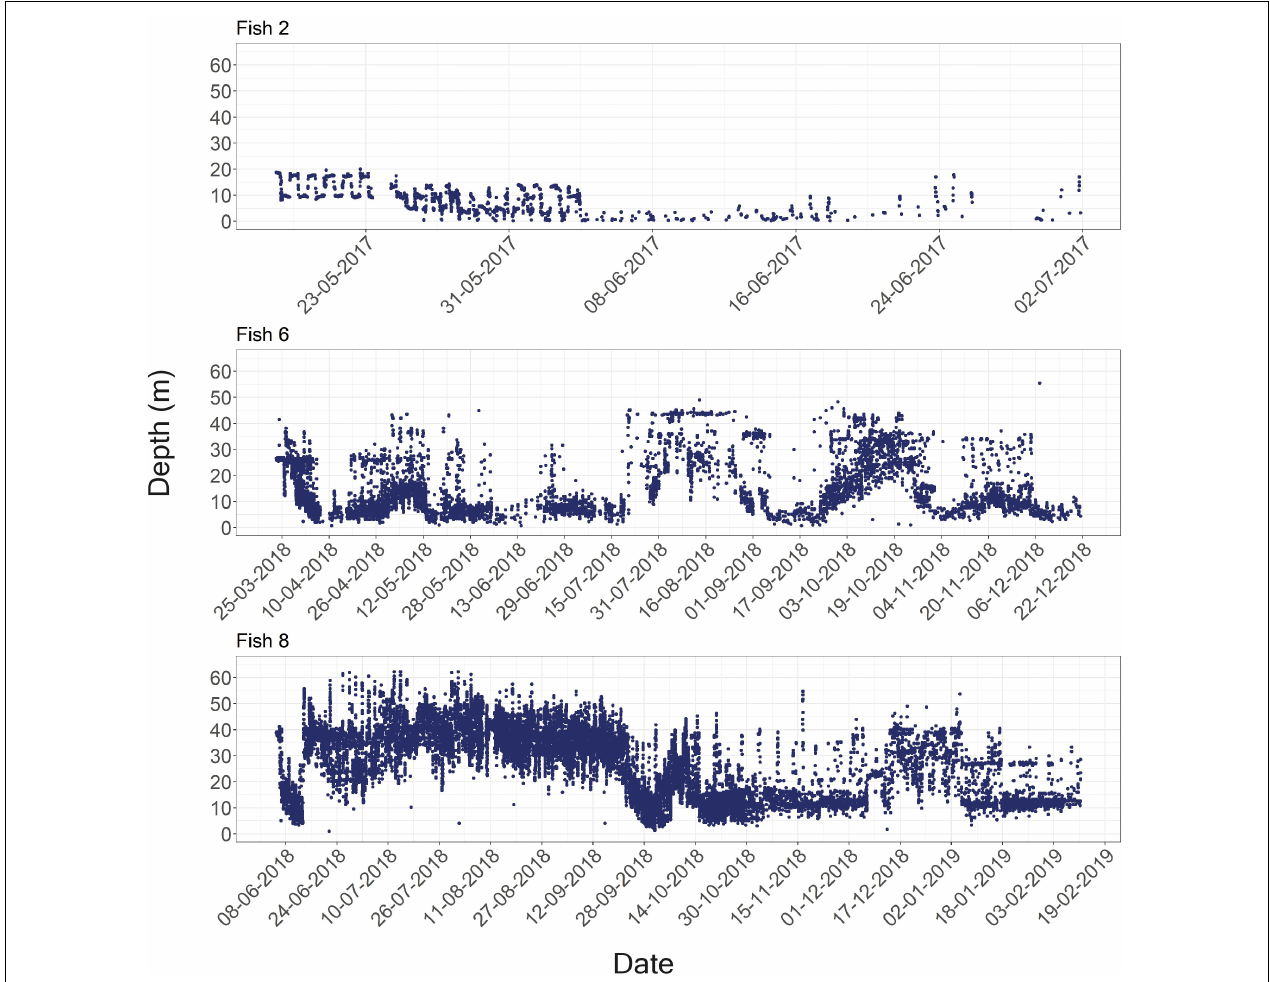
FIGURE 4 | Examples of the raw depth recorded for the entire period each fish was detected. Fish numbers two, six, and eight are shown above, and data for all fish in the study appear in Supplementary Material 4